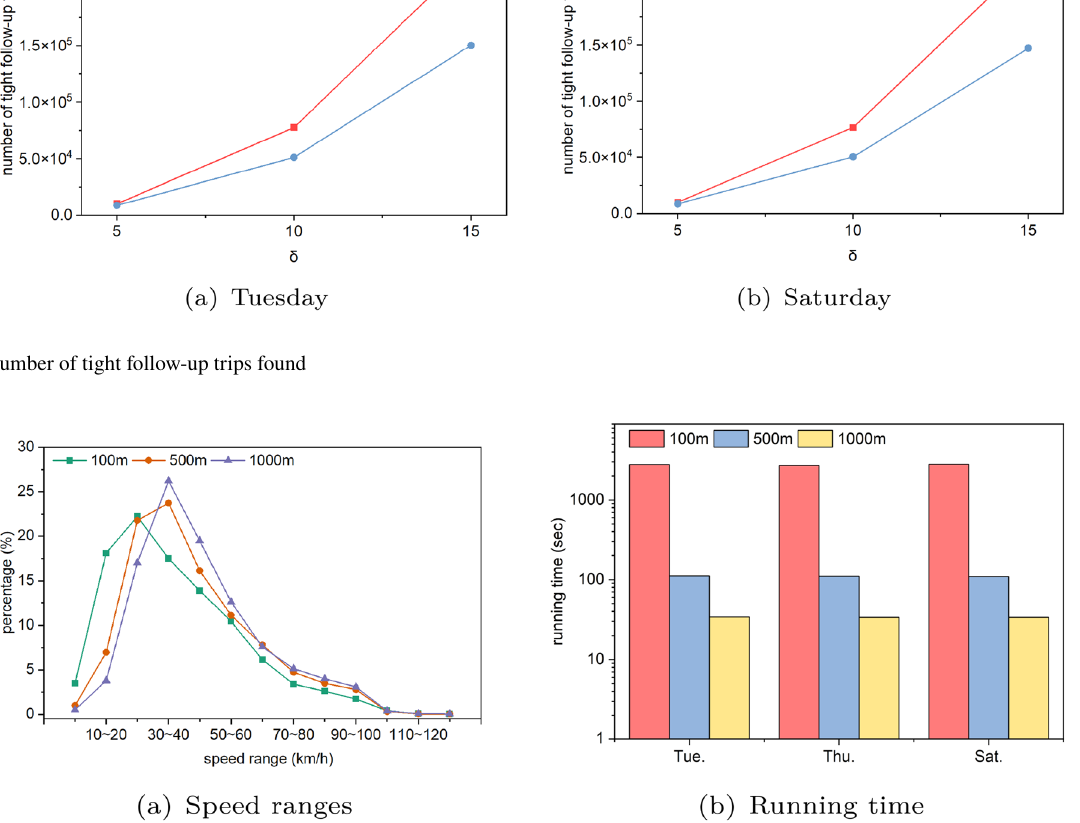
Fig. 19 Performances of trip-index-based-2 w.r.t. different grid sizes